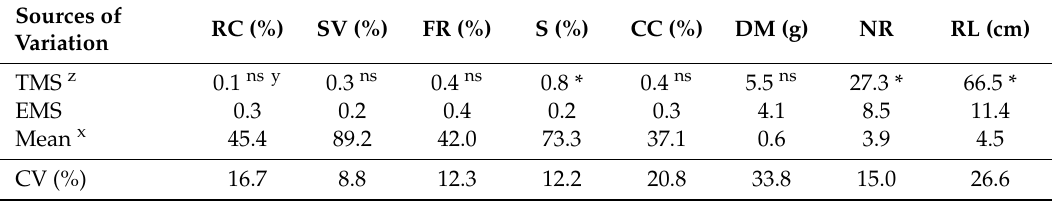
Table 1. Rooted cuttings (RC), survival (SV), foliar retention (FR), leaf retention (LR),